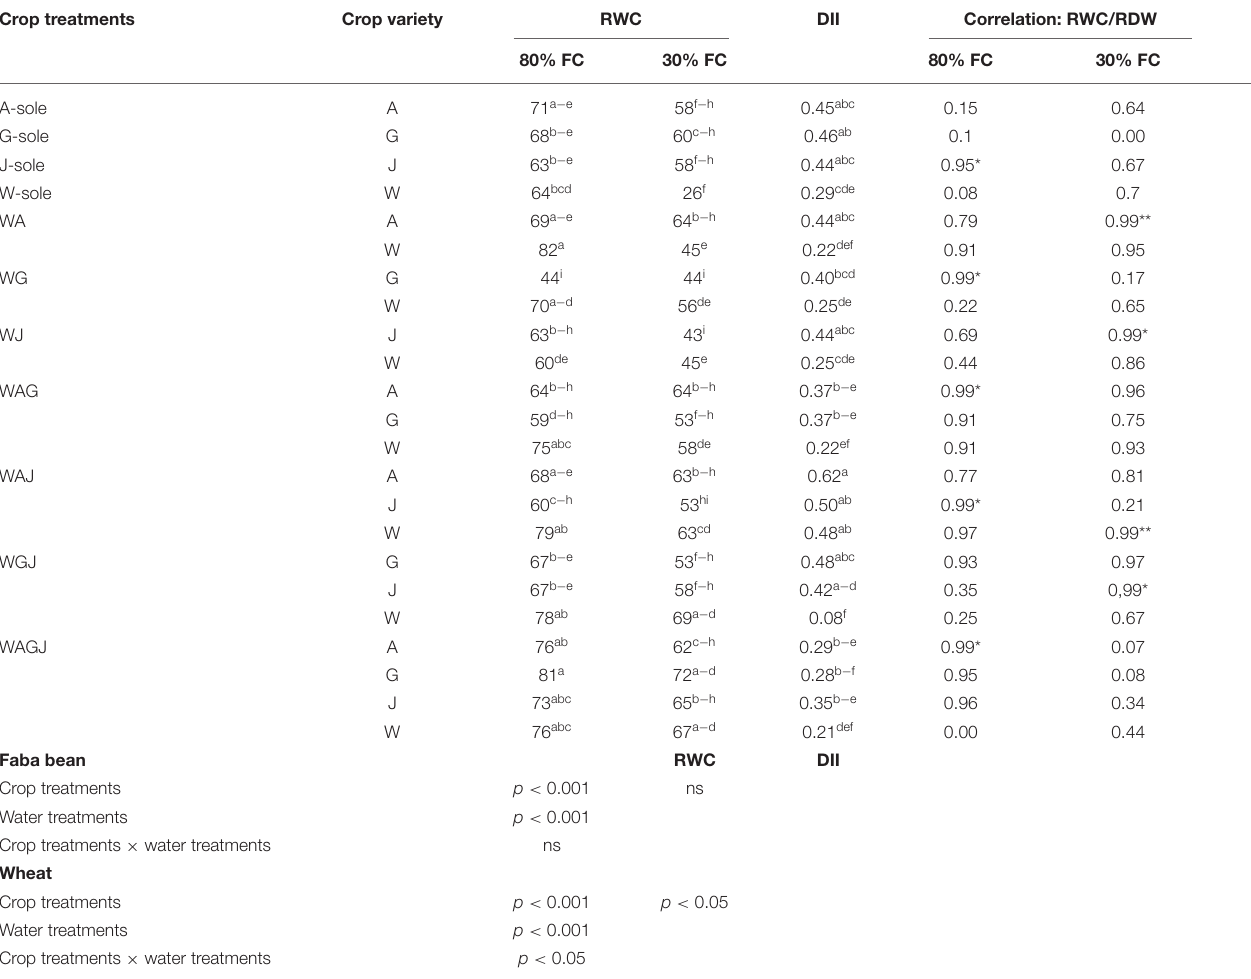
TABLE 1 | Leaf relative water content (RWC), drought intensity index (DII), and correlation coefficient ( R 2 as assessed by correlation analysis) between RWC and root dry weight (RDW) parameters of three faba bean varieties, Alexia (A), Gloria (G), and Julia (J), grown as sole crops (A-, G-, and J-sole) or under intercropping with wheat (W) (WA, WG, WJ, WAG, WAJ, WGJ, and WAGJ) under water sufficiency (80% field capacity) and water limitation (30% field capacity). Crop treatments